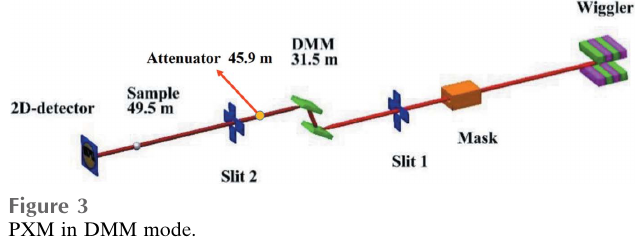
Figure 3 PXM in DMM mode.